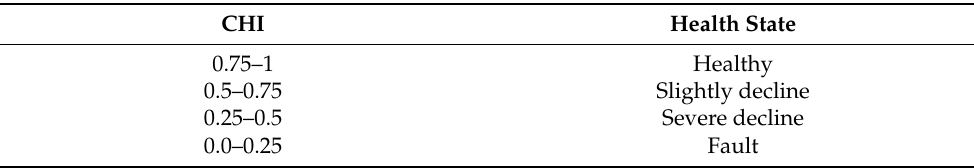
Table 1. System comprehensive health index range.